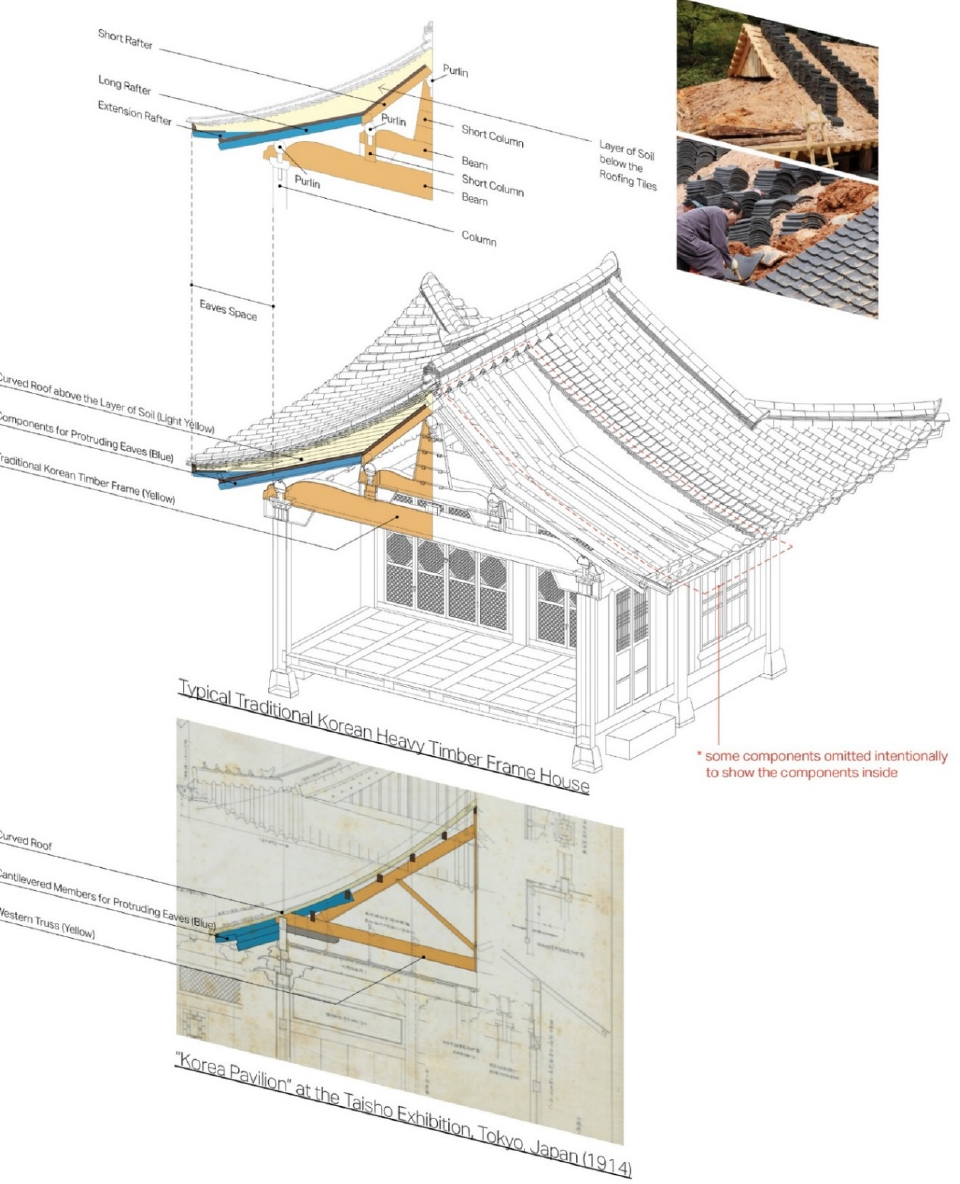
Figure 3. Comparison Diagram of Roofs. ( Bottom ) Original Drawings of the Korea Pavilion at the 1914 Tokyo Taisho Expo (redrawn by authors based on the drawings from the National Archives of Korea). ( Middle ) Details of a traditional Korean roof (drawn by authors). ( Top right ) Layer of soil (photos from Hanok Magazine